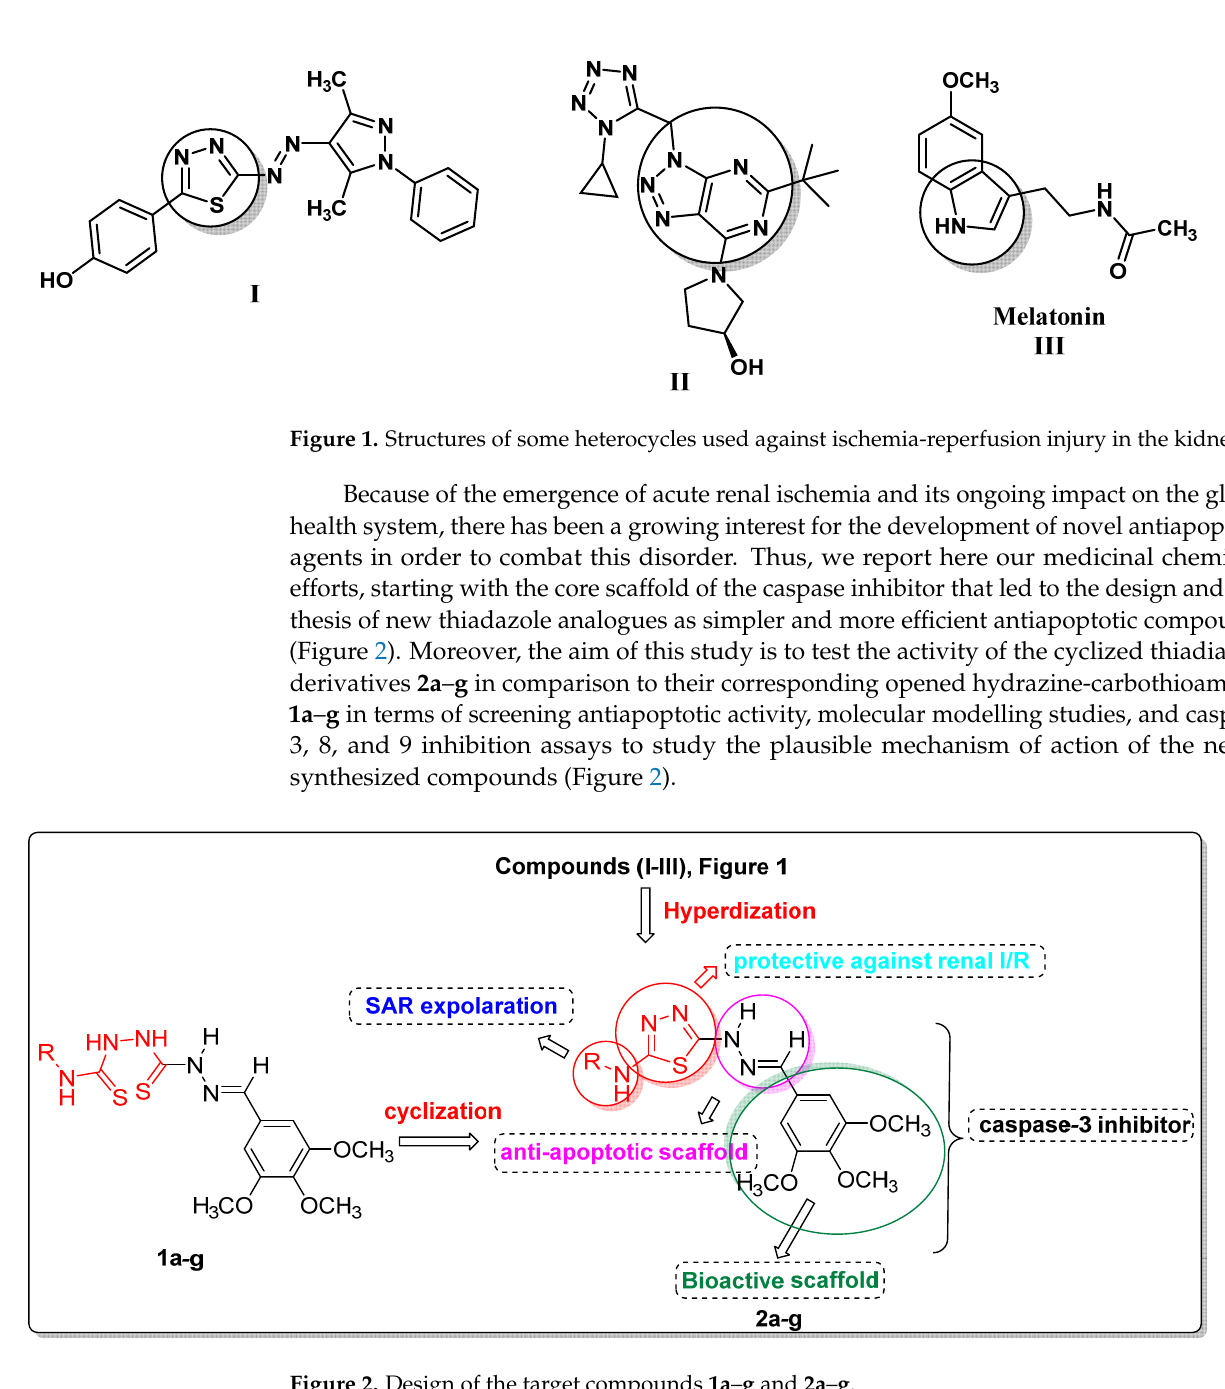
Figure 2. Design of the target compounds 1a–g and 2a–g.